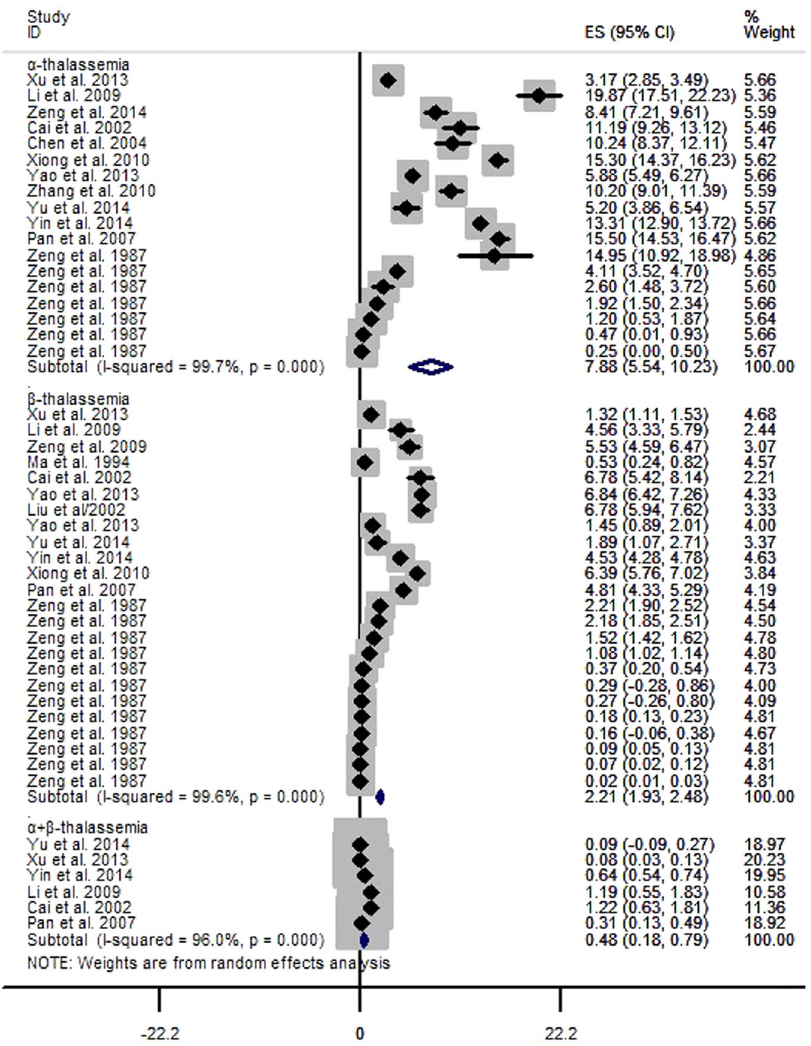
Figure 2. The pooled prevalence of thalassemia in mainland